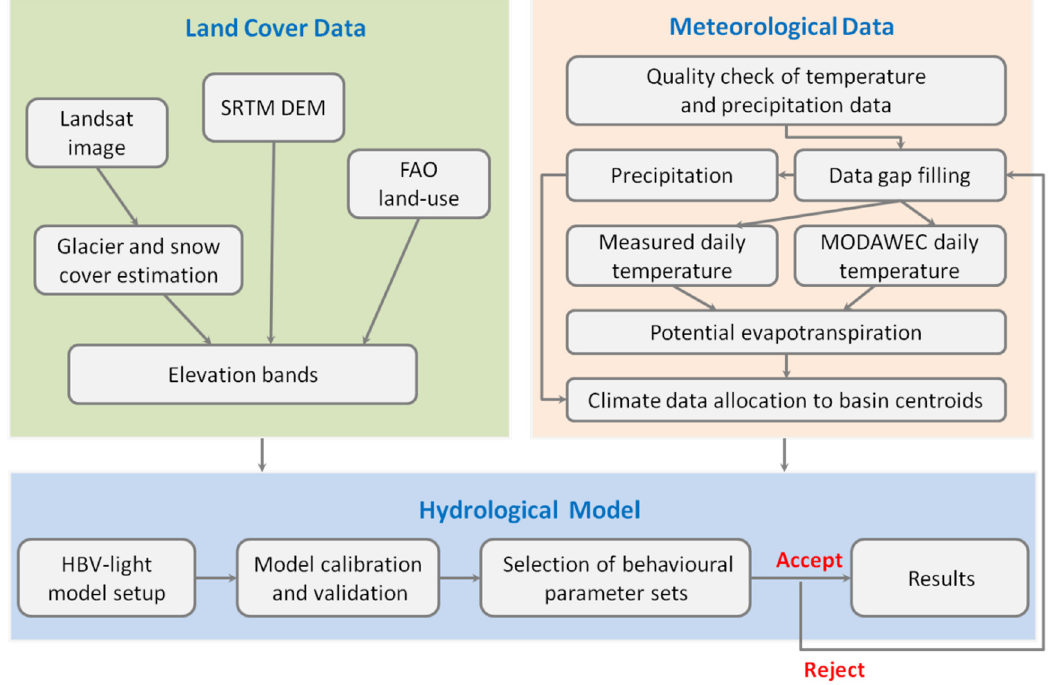
Figure 3. Schematic representation of the selected model